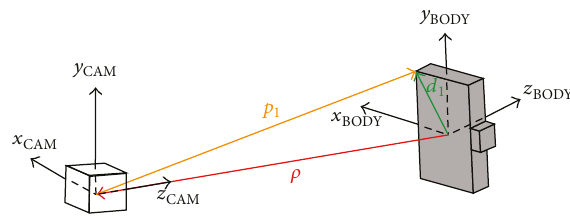
Figure 3: Picture representing the chaser pointing with its optical axes ̂ z 𝐶 directed towards the target’s centre of mass. The triangle made up by vectors 𝜌 (red), p 1 (orange), and d 1 (green) is shown for the generic point 1 to give a clear explanation of